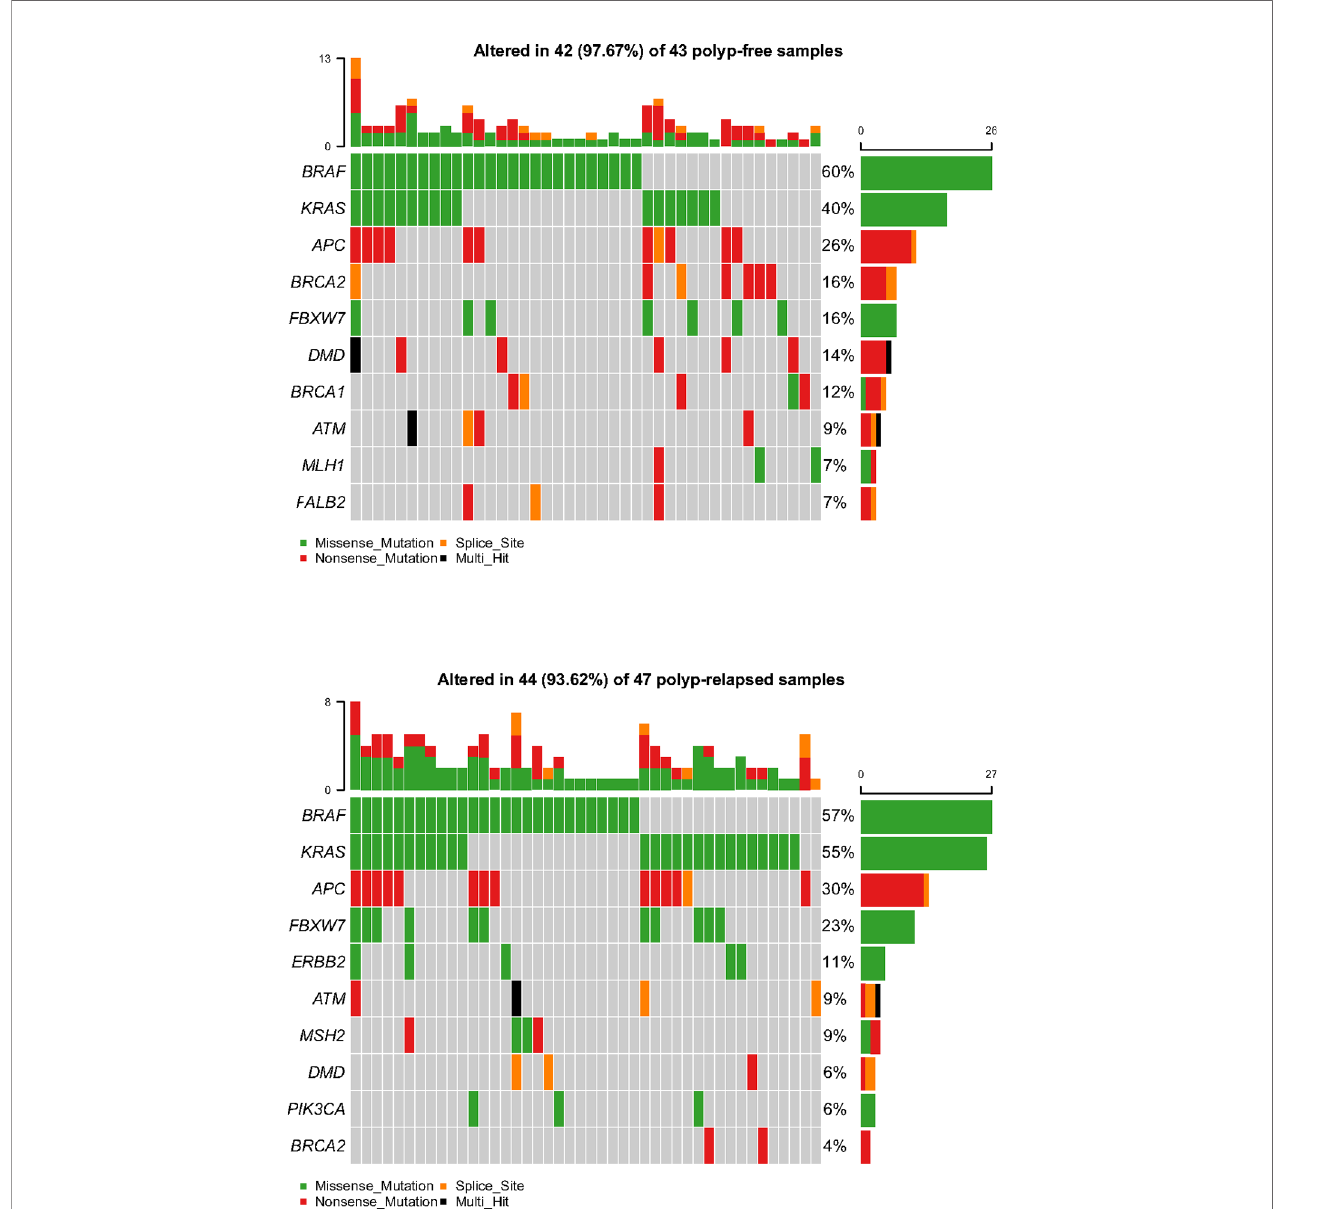
FIGURE 2 | Representative spectrum of frequently mutated genes in polyp-relapsed and polyp-free colorectal serrated polyps after variant fi